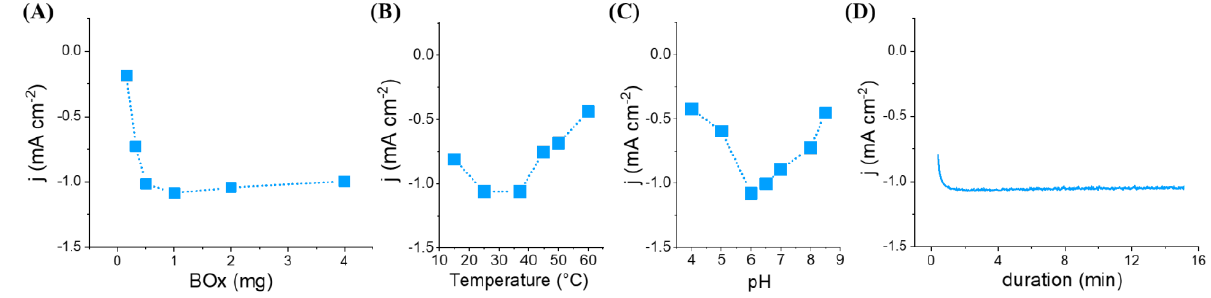
Figure 2. ( A ) Influence of various amounts of BOx entrapped inside the hollow electrode based on hemin-L bp on the electrocatalytic reduction of O 2 . Applied potential 0.5 V vs. RHE. Faradaic catalytic current recorded at 0.5 V on a hollow electrode based on hemin-L bp in oxygen-purged 0.1 M phosphate buffer and containing 2 mg of BOx; ( B ) plot of the current as a function of temperature at pH 6.5; ( C ) Plot of the current as a function of pH at 25 °C. ( D ) Chronoamperometric measurement at 0.5 V in oxygen-purged 0.1 M phosphate buffer (pH 6.5) at 25 °C.